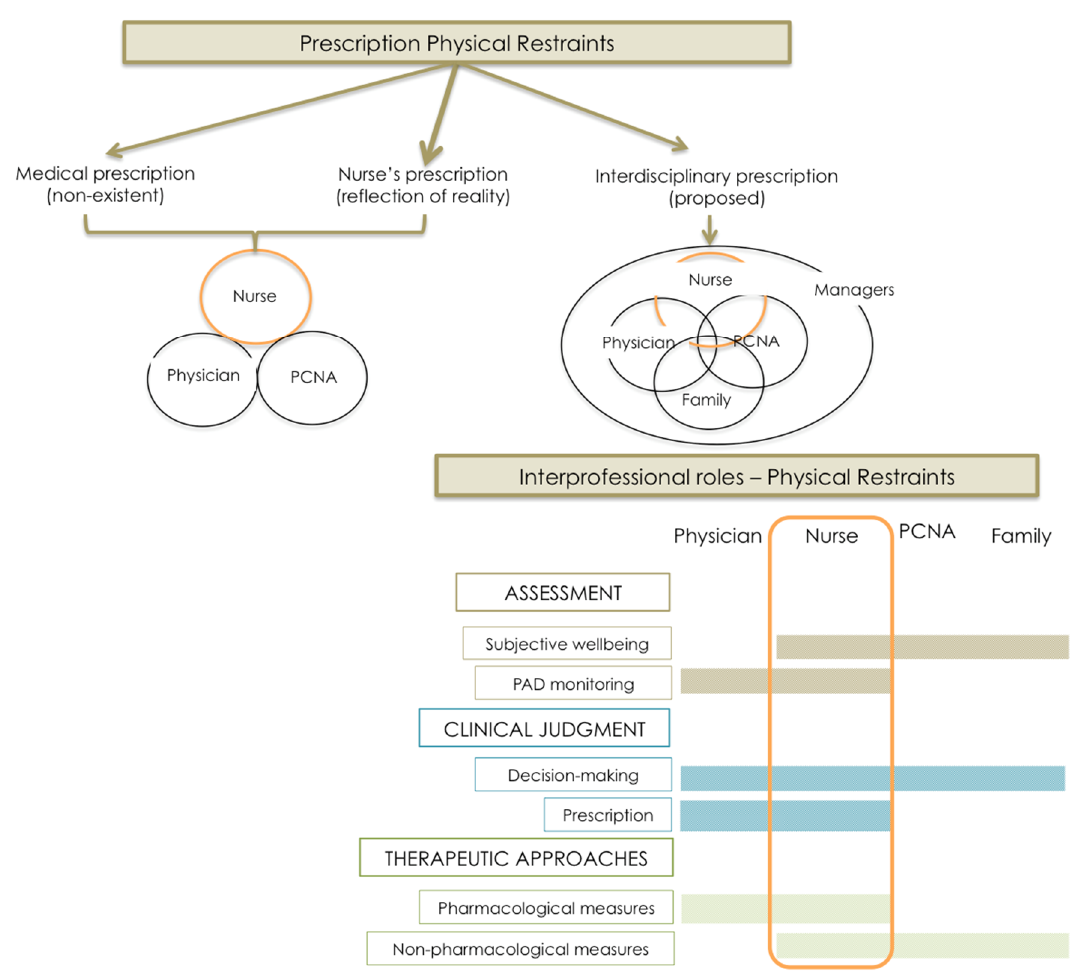
Figure 12. Proposed physical restraints prescribing and interprofessional roles. Abbreviations: PCNA: patient care nursing assistant; PAD: pain/agitation-sedation/delirium.